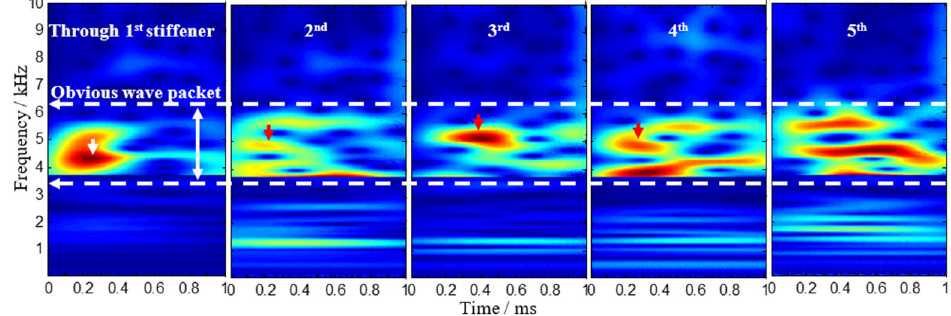
Figure 5. Continuous wavelet transforms on typical outputs of the PZT sensors after filtering.